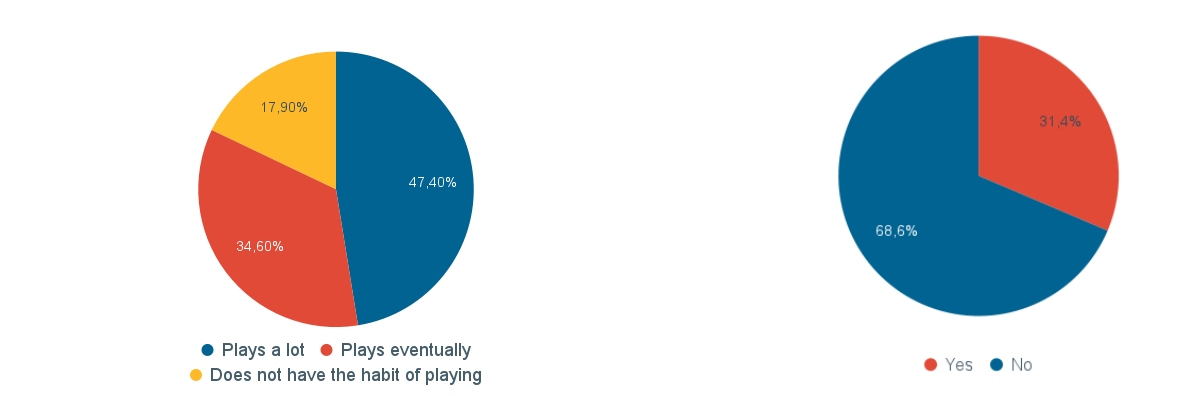
Figure 16. Do you have the habit of playing video games? - Test 1.